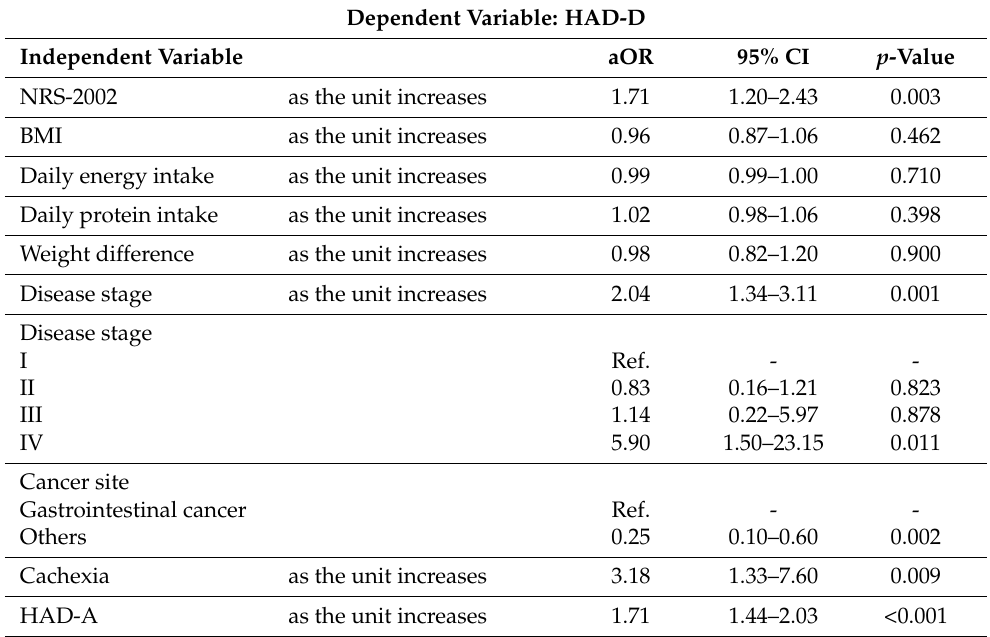
Table 2. Ordered logistic regression. The odds ratio adjusted for age and sex are